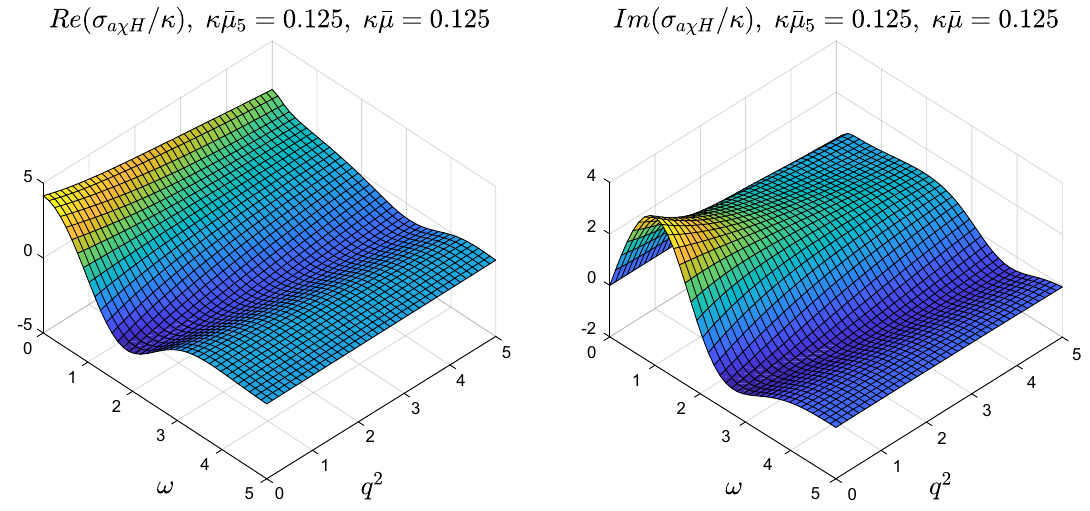
Fig. 8 Anomalous chiral Hall TCF σ a χ H /κ as a function of ω and q 2 when κ ¯ μ = κ ¯ μ 5 = 1 /